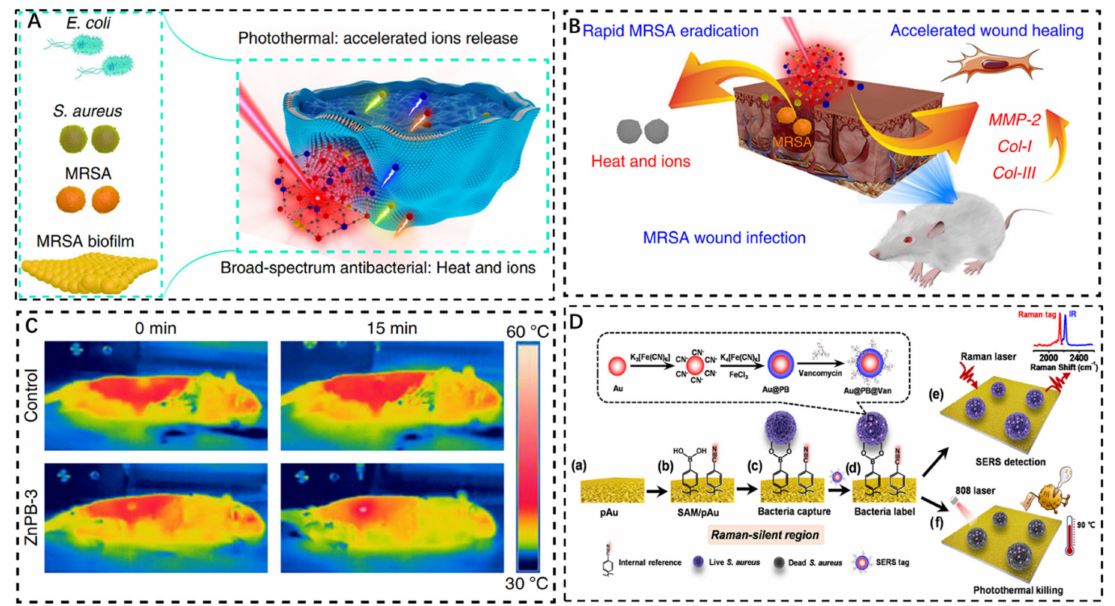
Figure 6. ( A ): Germicidal mechanism of ZnPB as exogenous antibacterial agent. ( B ): MRSA removal process in wound surface by ZnPB − 3 photothermal treatment. ( C ): PTT comparison results of no NIR and znPB − 3 irradiation for 15 min [72]. ( D ): Illustration of in situ photothermal sterilization of SERS platform [73]. Copyright application has been